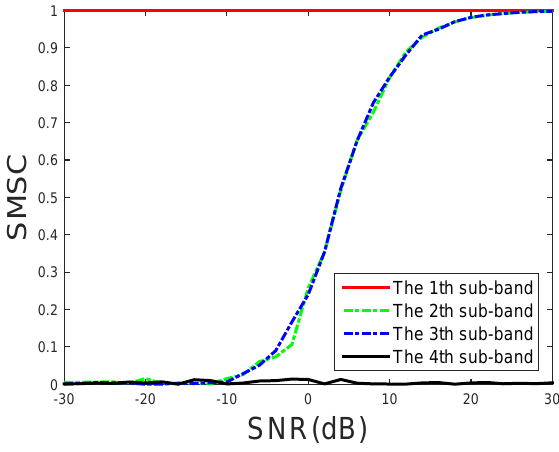
Figure 5. The SMSC under different